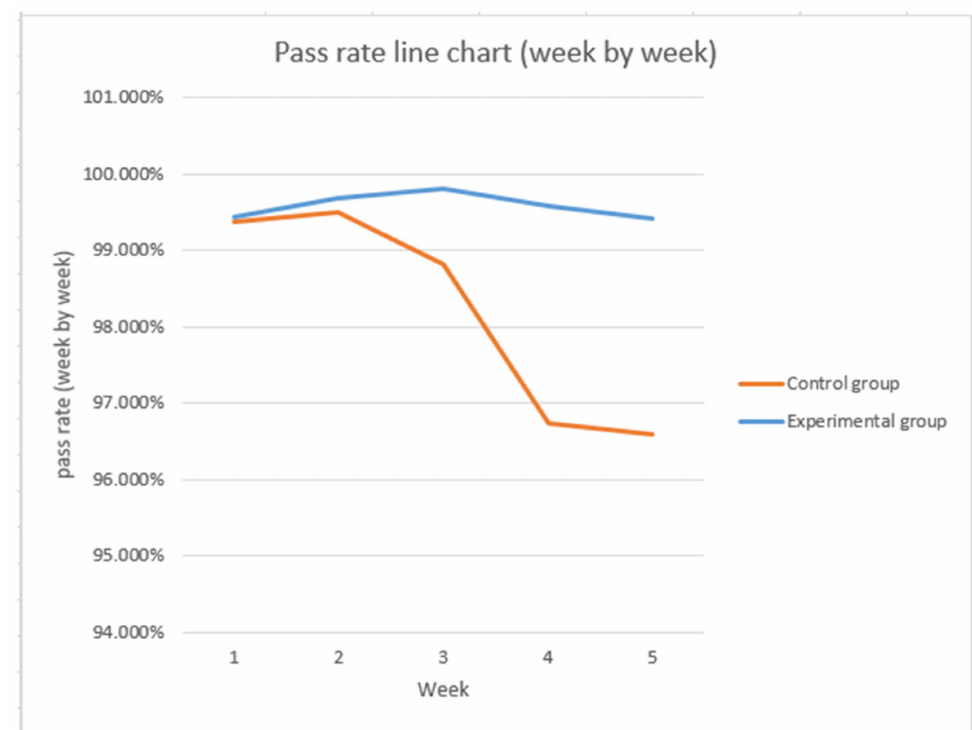
Figure 39. Line chart presenting the weekly pass rates of the students.